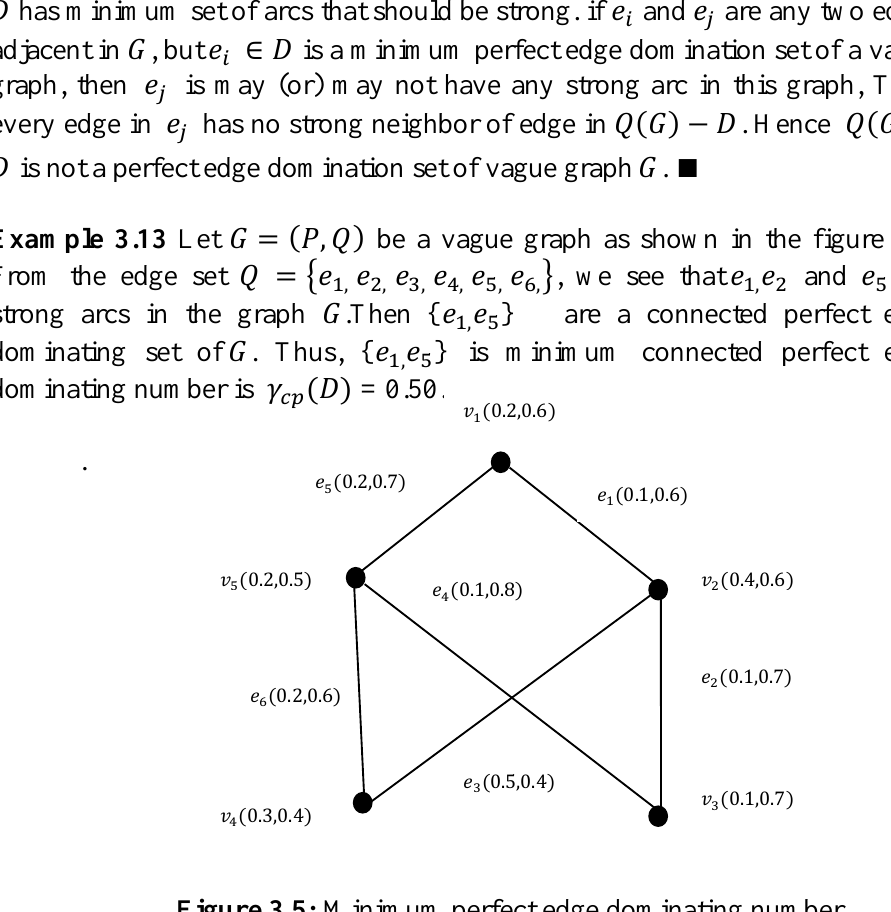
Figure 3.5: Minimum perfect edge dominating